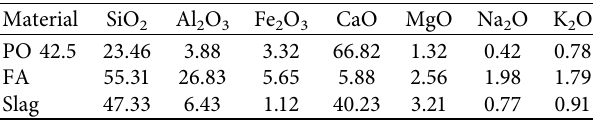
Table 1: Chemical composition of main raw materials (in